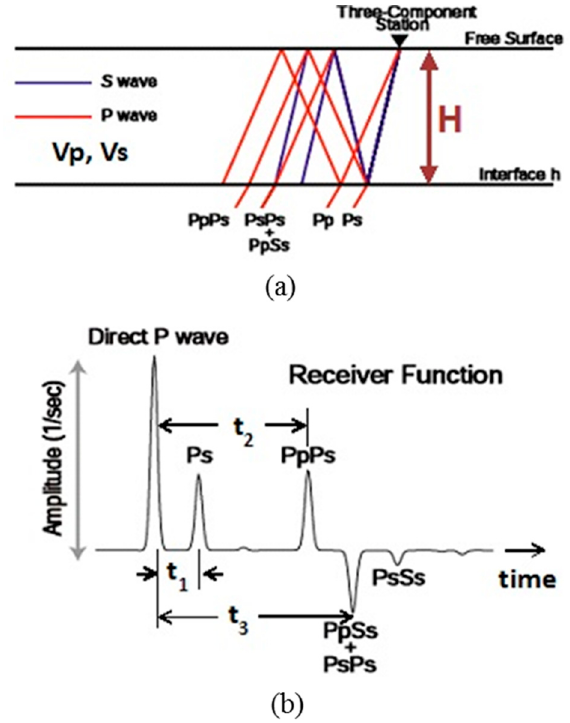
Figure 1. ( a ) A three-component seismic station, a simplified one-layer crustal earth model of thickness H, and different seismic phases; ( b ) receiver function corresponding to the given crust and impinging P-wave (modified from an original in C. J. Ammon [23]).